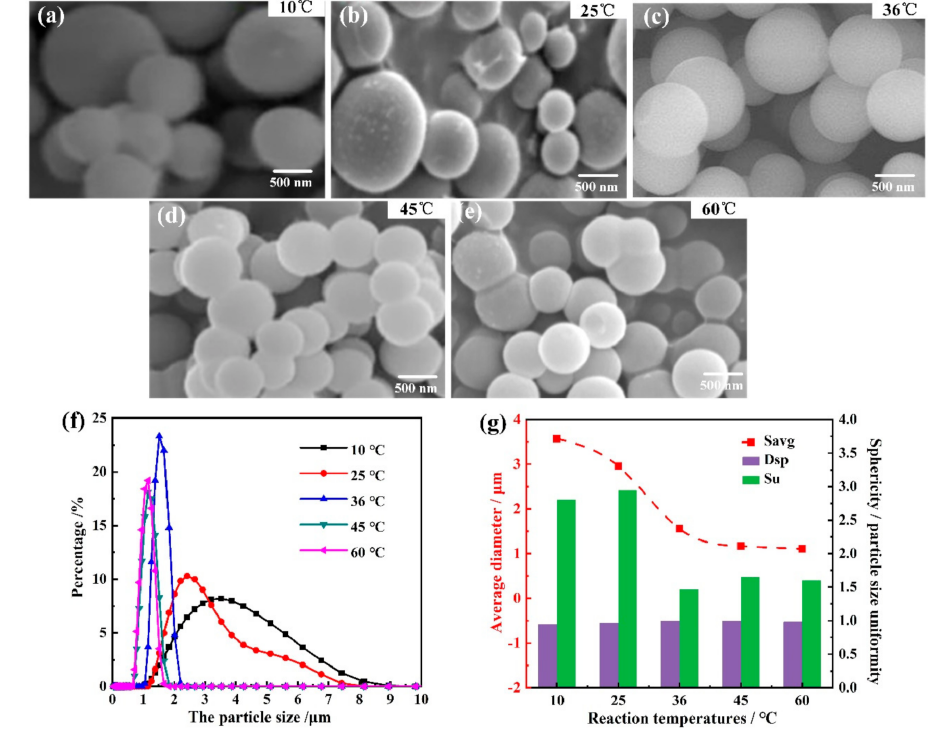
Figure 4. Morphology and particle size distribution of as-prepared PMSQ microspheres with different reaction temperatures. ( a – e ) SEM images at different reaction temperatures; ( f ) the particle size and distribution of the PMSQ microspheres; and ( g ) average diameter, sphericity, and particle size uniformity of PMSQ microspheres with different reaction